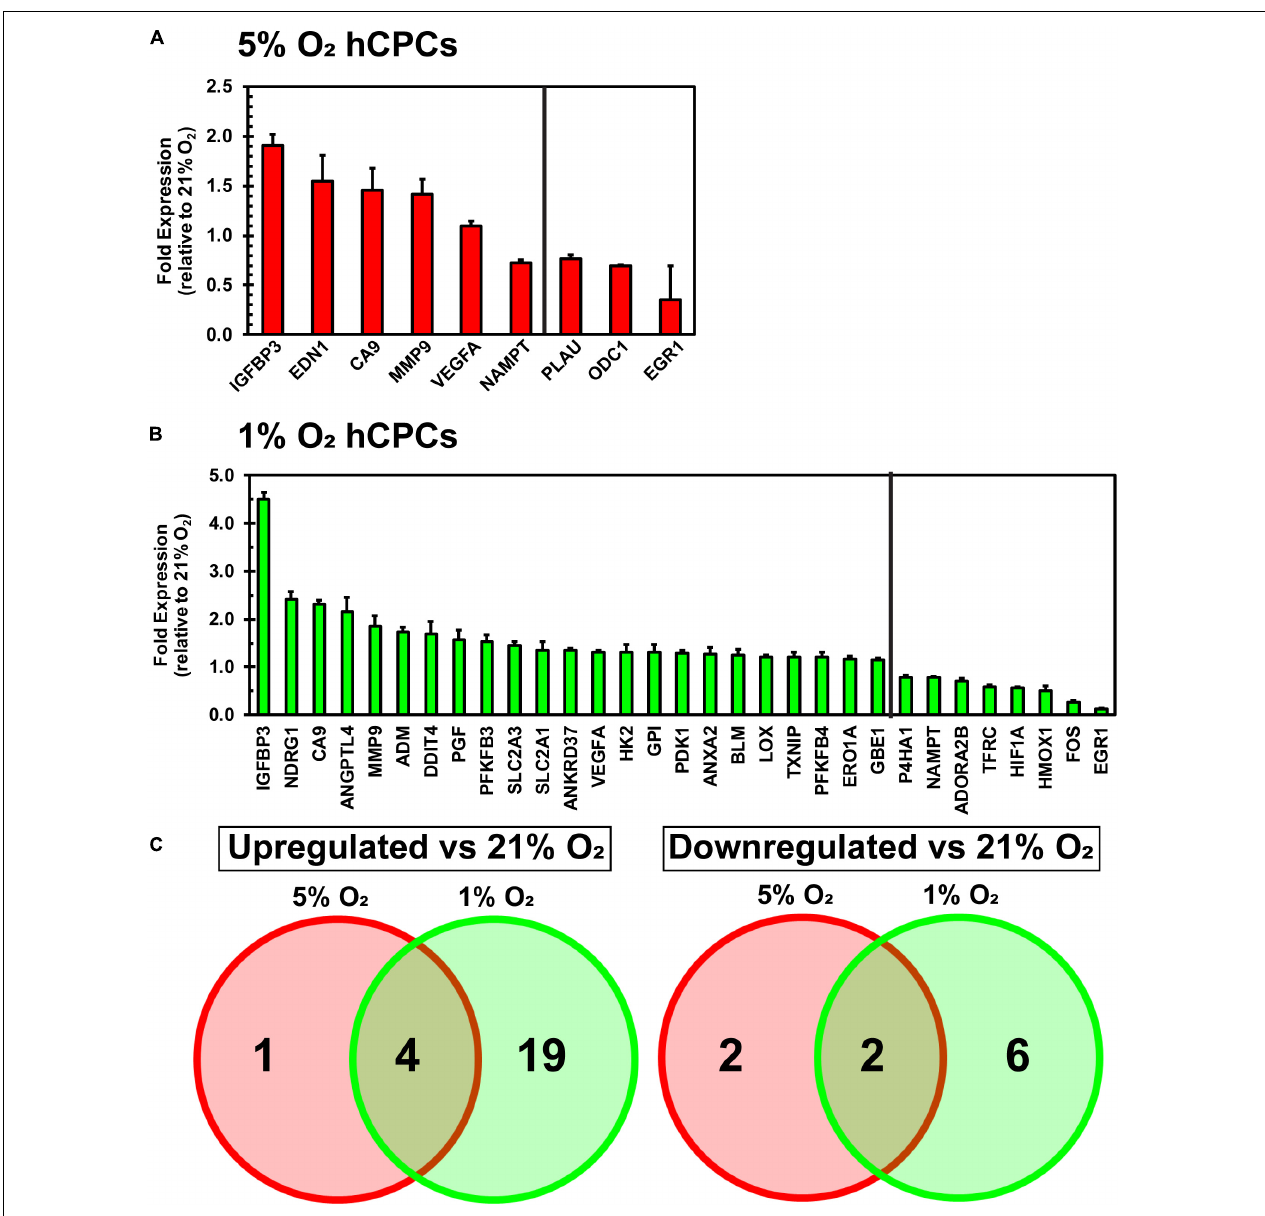
FIGURE 3 | Culturing hCPCs under hypoxia modulates hypoxic gene expression. hCPCs were cultured under 21, 5, and 1% O 2 for 48 h then total RNA was harvested and gene expression analyzed via real-time PCR. Gene expression was normalized to five housekeeping genes and calculated as a fold change relative to levels at 21% O 2 . (A) 5% O 2 culturing of hCPCs significantly increased expression of five genes, and significantly decreased expression of four genes. Data represented as mean ± SD, n = 3, all have p < 0.05 as compared to 21% O 2 . (B) 1% O 2 culture altered expression of numerous hypoxia-related genes. 23